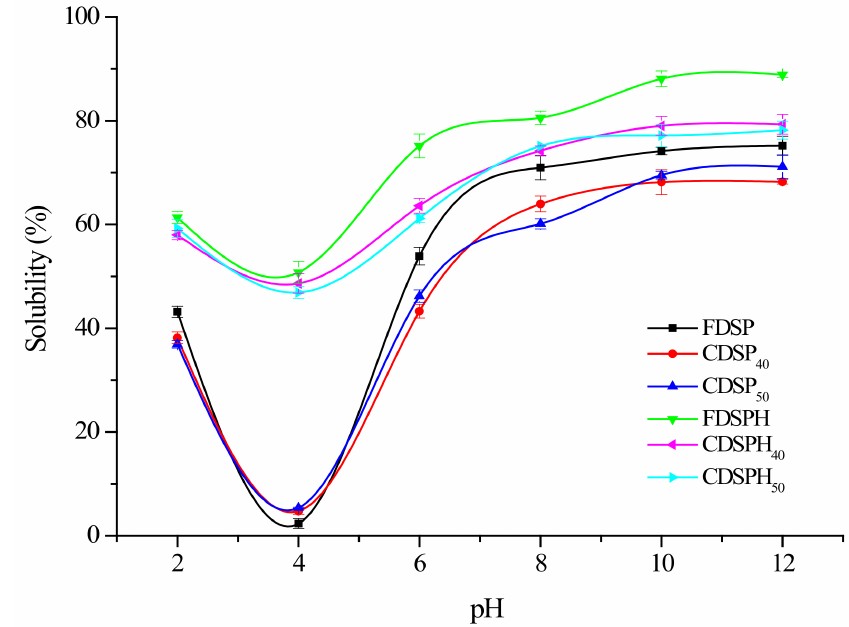
Figure 1. Solubility of freeze- and convectively-dried SP and